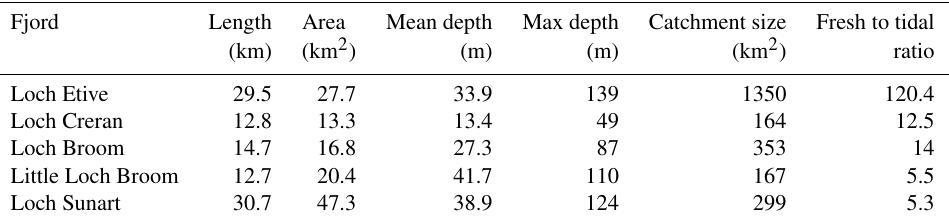
Table 1. Key physical characteristics (Edwards and Sharples, 1986) of each of the five fjords selected to produce detailed estimates of sedimentary C